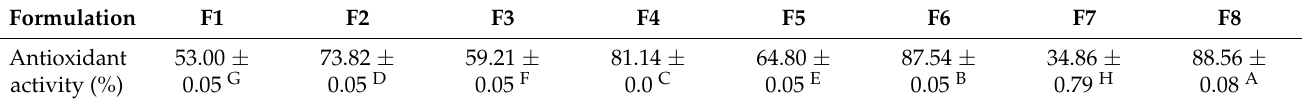
Table 2. Antioxidant activity of formulations F1 to